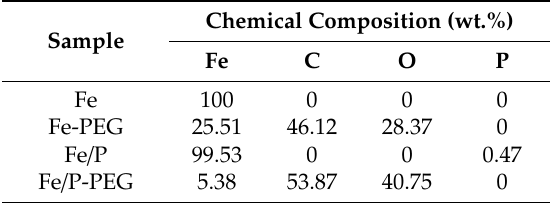
Table 2. Chemical composition of the surface of sintered iron-based foams determined from energy dispersive spectroscopy (EDX) analysis.